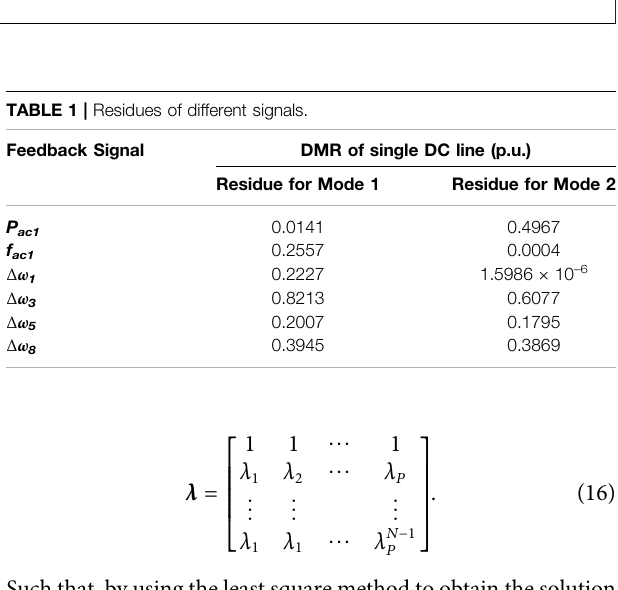
FIGURE 9 | Test system with VSC-HVDC.